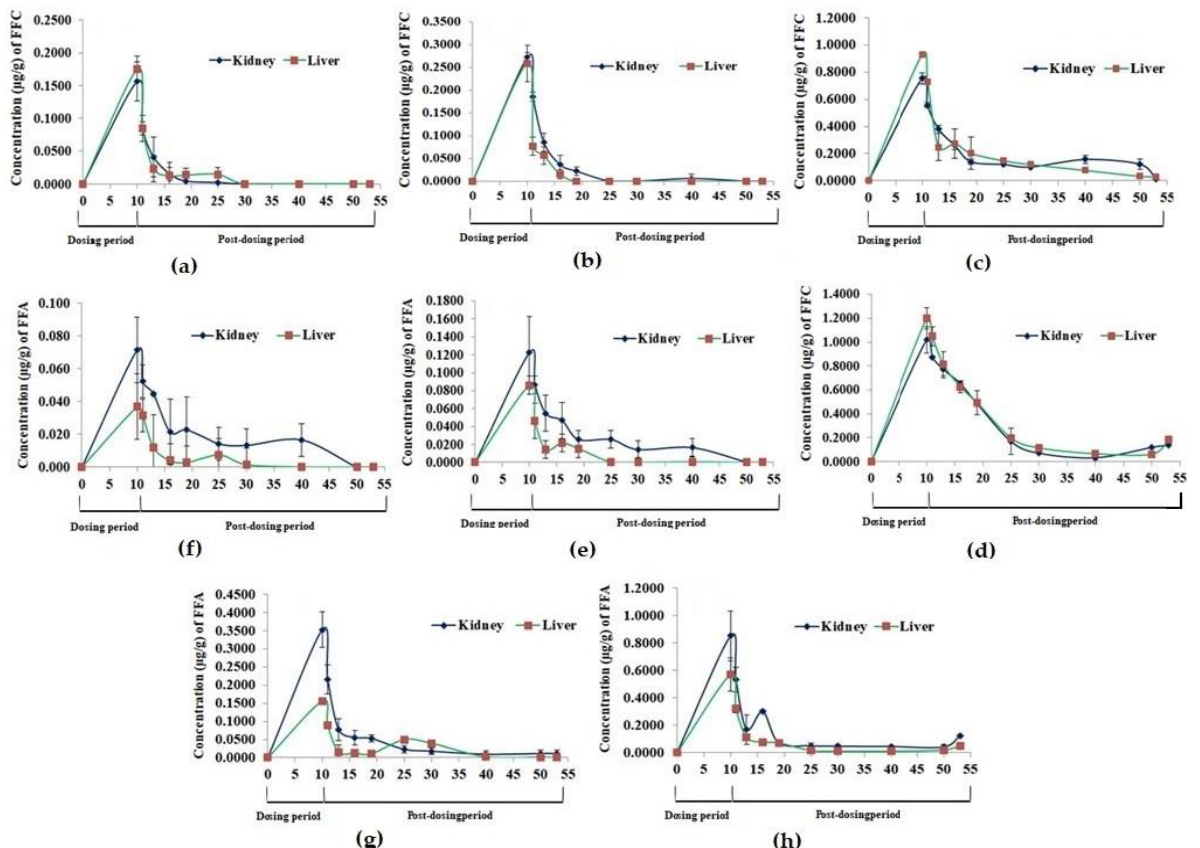
Figure 2. Florfenicol (FFC) and florfenicol amine (FFA) accumulation and depletion profile in Oreochromis niloticus juveniles’ kidney and liver tissues upon dietary FFC administration at 0–10 times the therapeutic dose of 15 mg kg biomass − 1 day − 1 for 10 consecutive days. ( a , e ) 15 mg FFC; ( b , f ) 45 mg FFC; ( c , g ) 75 mg FFC; ( d , h ) 150 mg FFC.